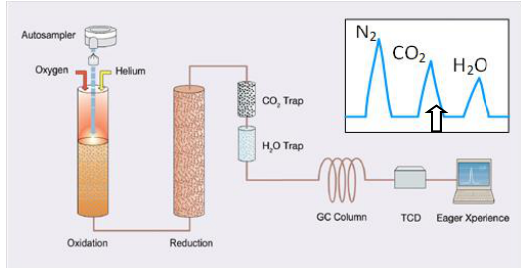
Fig. 1. Schematic diagram of a gas chromatography for the determination of the mass fractions of carbon C, hydrogen H and nitrogen N in a liquid fuel